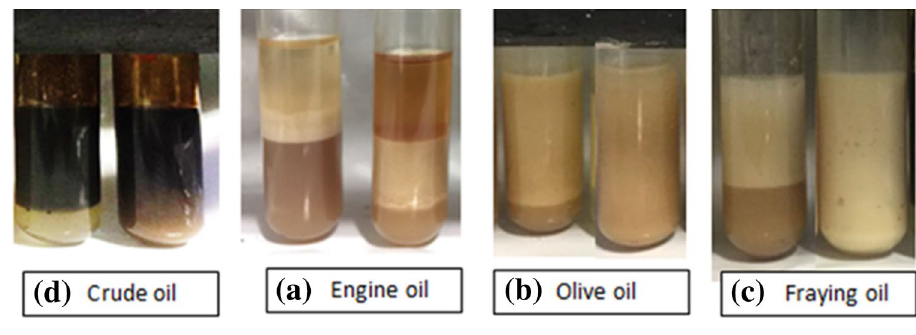
Fig. 8 Emulsification activity test with different oils left tube −49, right −36